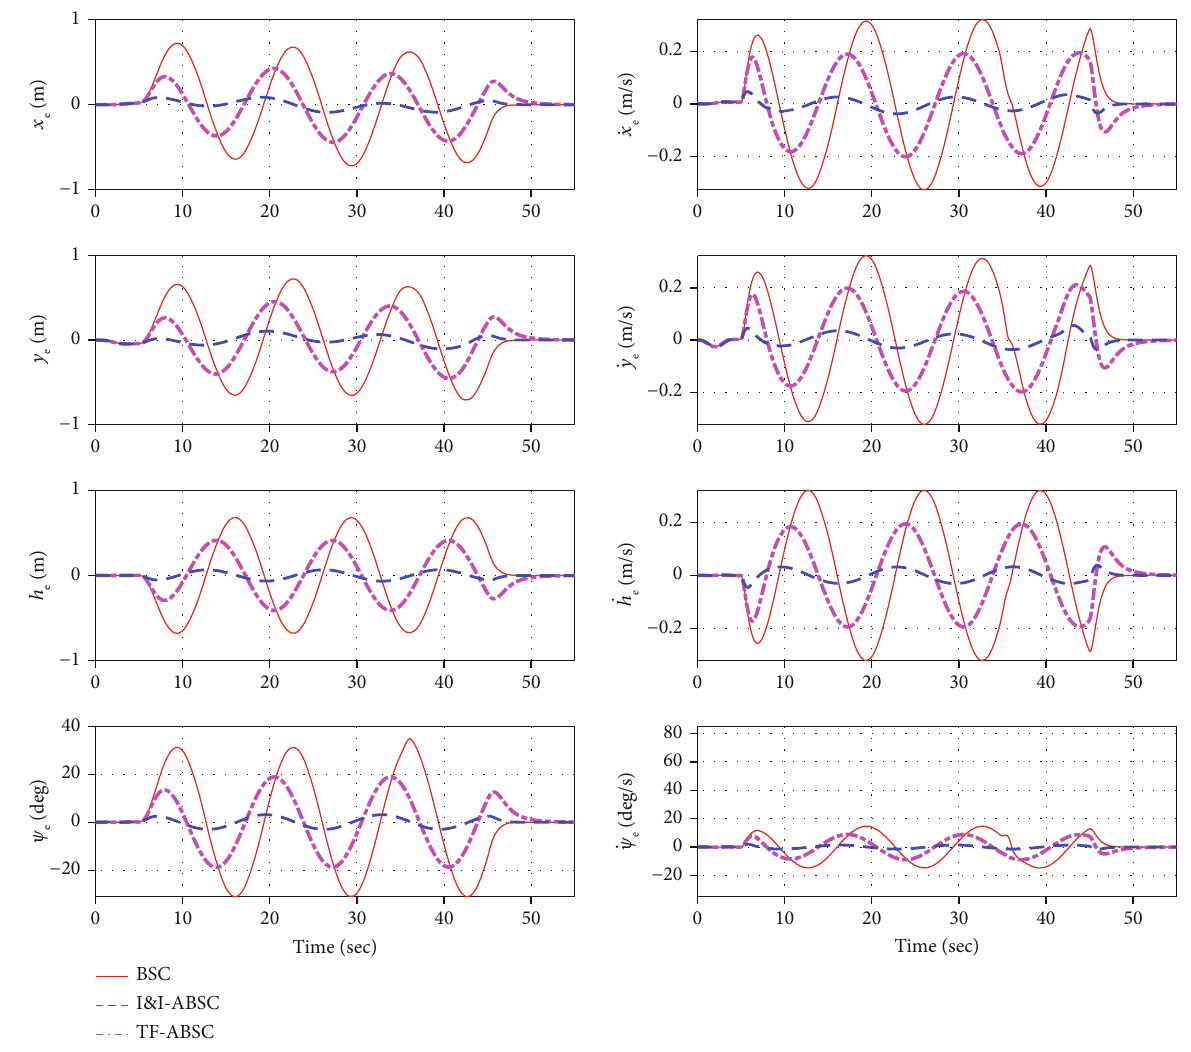
Figure 6: Case A: position and velocity tracking errors of BSC, TF-ABSC, and I&I-ABSC. Table 1: Case A: root-mean-squared tracking